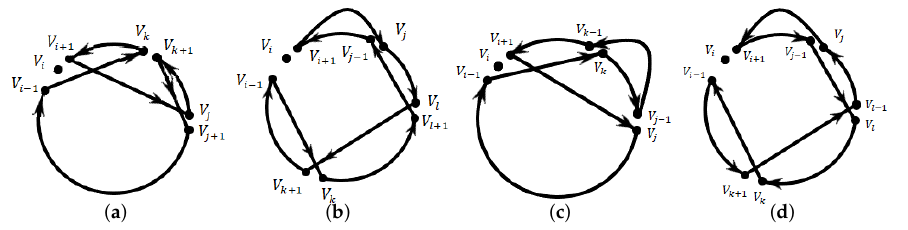
Figure 3. ( a ) Unstringing Type I, ( b ) unstringing II, ( c ) unstringing Type III, and ( d ) unstringing Type IV.